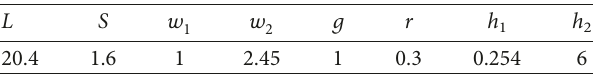
Figure 5: (a) 8 × 8 metasurface array structure and (b) details of the microstrip transmission line- (TL-) based combining network. Table 2: Optimized dimensions of the 6mm air gap unit cells.